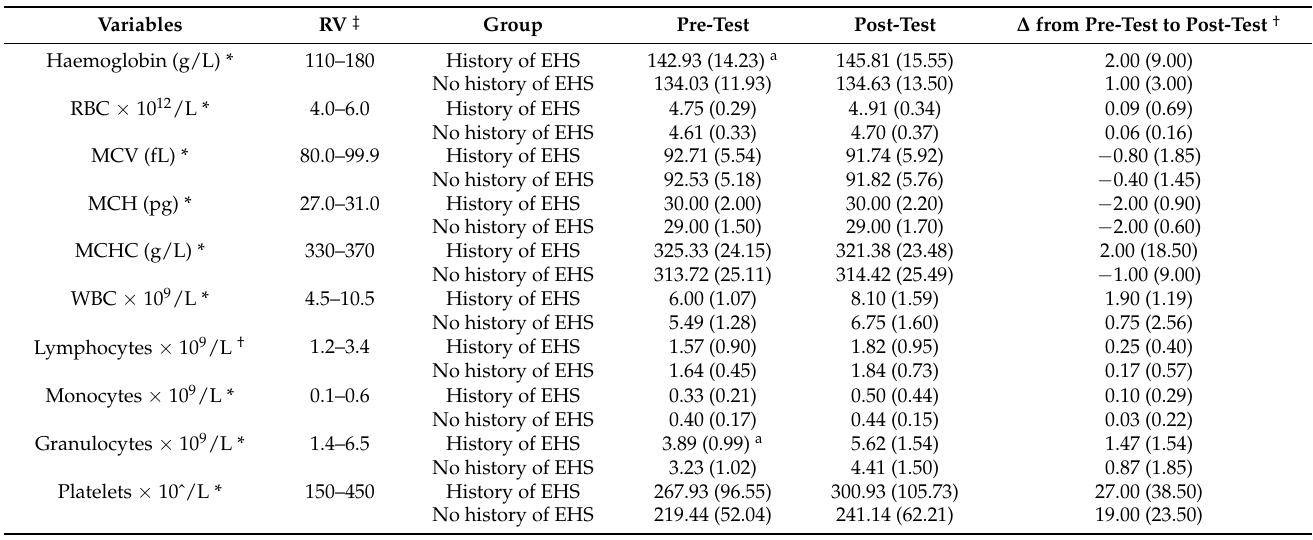
Table 3. Differences in haematological variables between participants with and without a history of EHS.